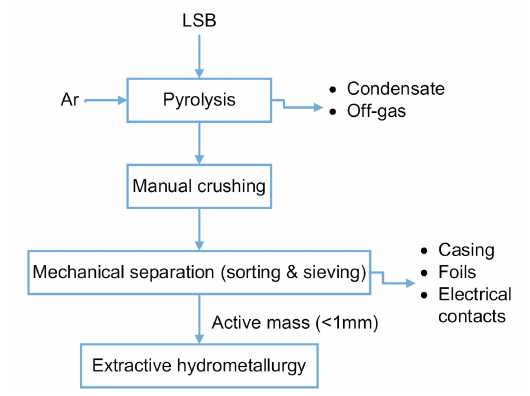
Figure 1. General process for a lithium–sulfur battery (LSB) recycling process based on extractive hydrometallurgy for elemental